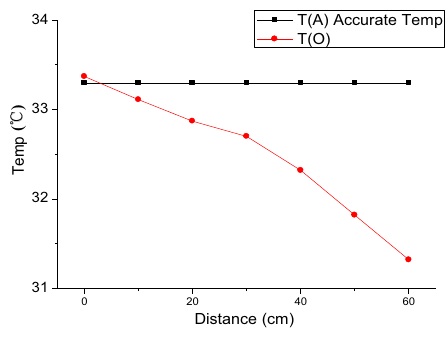
Figure 2. T(O), T(A) of subject C